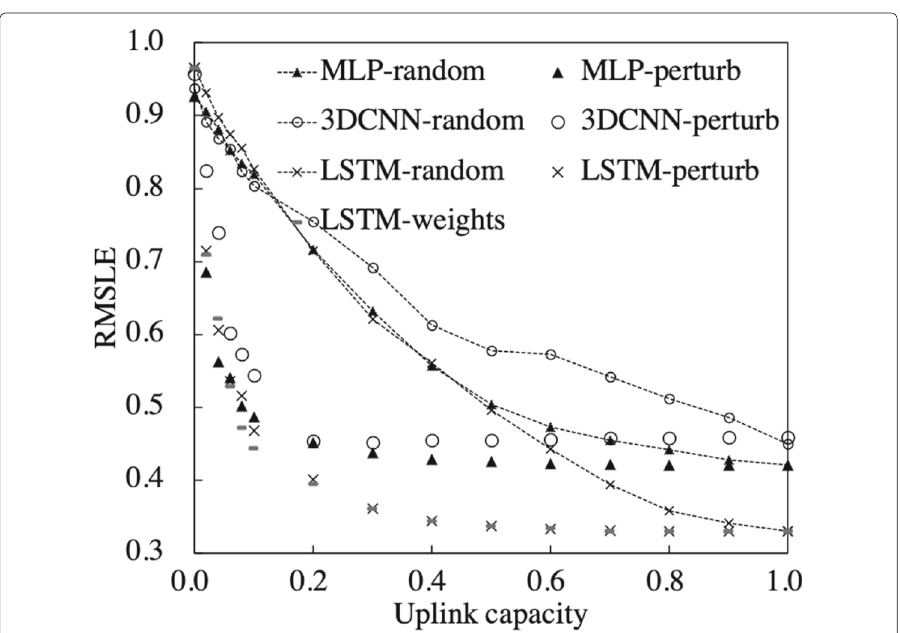
Fig. 5 Prediction accuracy (RMSLE) vs. uplink capacity obtained using neural network-based methods (MLP, 3D-CNN, and LSTM) for prediction. “Perturb” or “weights” method was used for feature selection